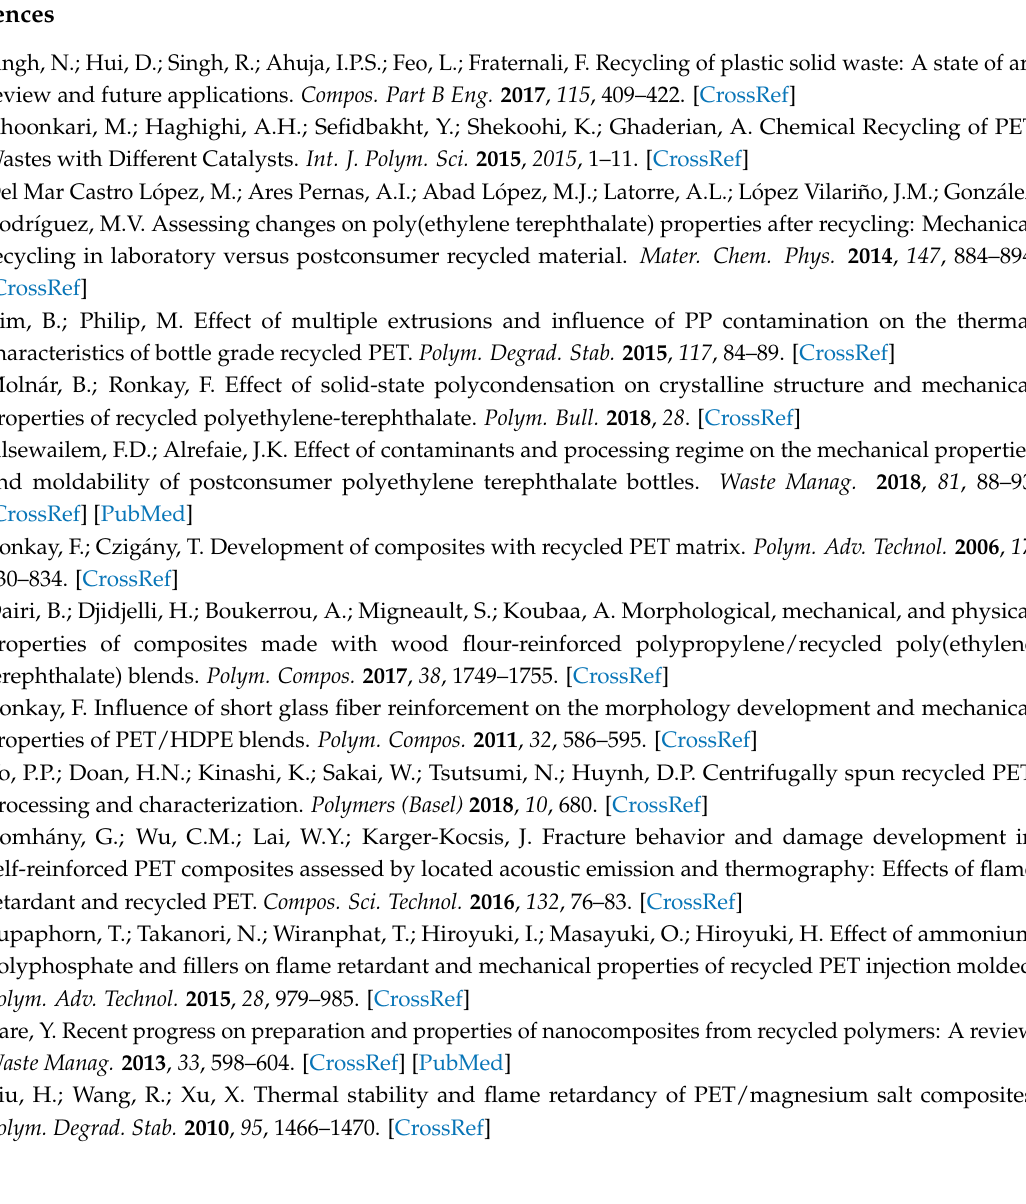
Figure S1: DSC curves of the rPET nanocomposites Author Contributions: F.R. and F.S. conceived and designed the experiments. F.S., B.B. and K.B performed the flame retardancy tests. F.S. and B.M. performed the mechanical tests. I.E.S. performed the X-Ray experiments. F.R and B.M. done the pilot experiment. F.R., D.N and K.B. wrote the paper. All authors discussed the results and improved the final text of the